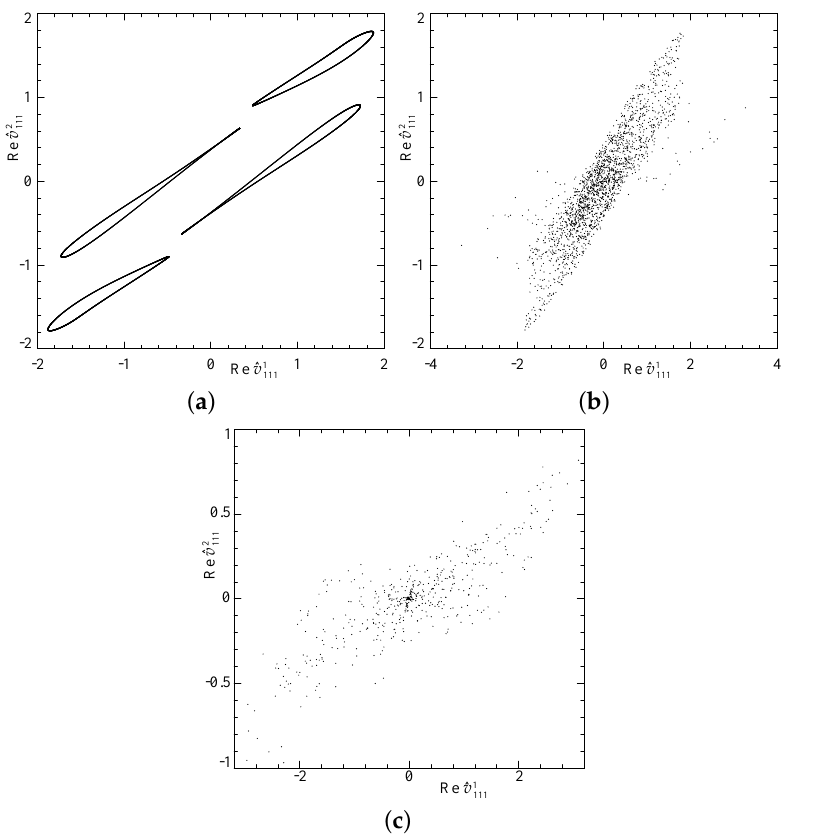
= 0 on the plane (Re ˆ v 1 ,Re ˆ v 2 ) 222 111 111